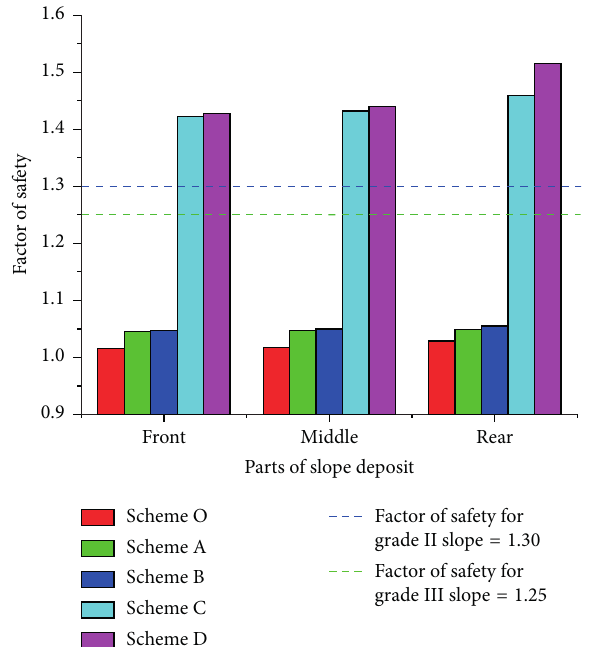
Figure 6: Changes in the FOS of the deposit slope for different reinforcement systems.